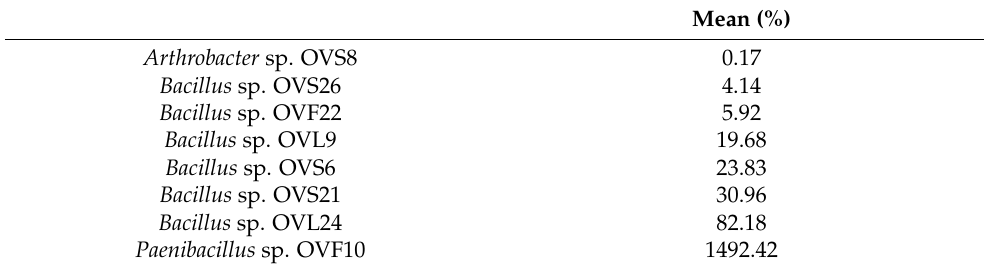
Table 1. Antibacterial activity of endophytic tester strains against target bacteria belonging to the Bcc. Values represent the mean percentage of number of viable cells of target strains in the presence of tester strains with respect to the number of viable cells grown in the absence of tester bacteria. The lower the value, the higher the antibacterial activity of the VOCs emitted by the